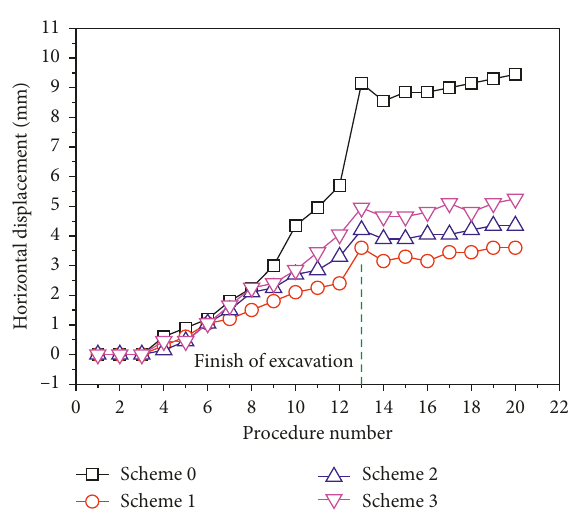
Figure 8: Horizontal displacement curve of the tunnel structure.